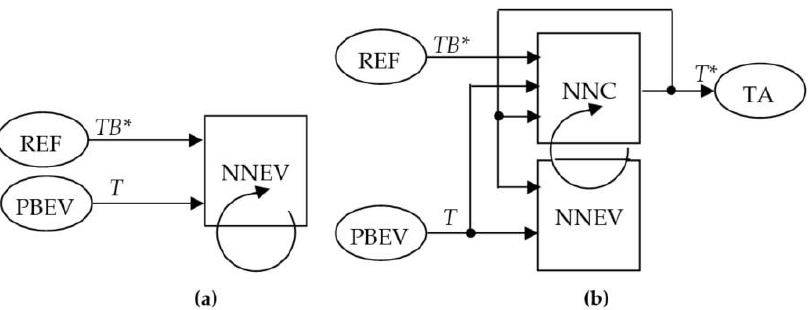
Figure 5. Two phases of the MRC design: ( a ) identification of the NNEV and ( b ) training the NNC.